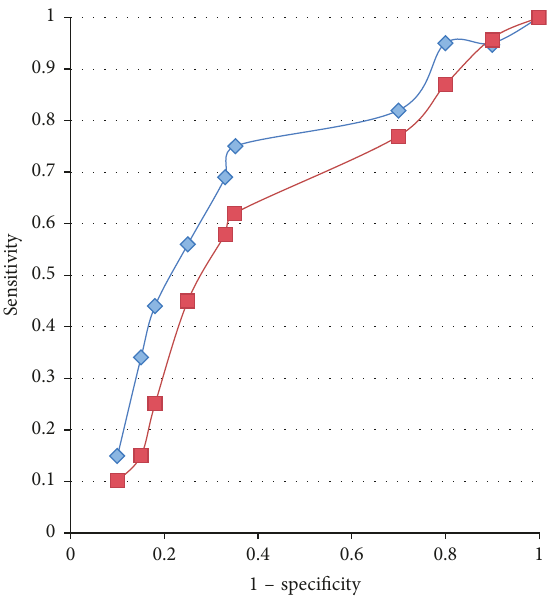
Figure 3: ROC curves corresponding to the sensitivity and specificity of possible cutoff points for changes in Rrs (diamonds) and Xrs (squares) pre- and postsalbutamol for discriminating children with asthma (control and uncontrol) and without